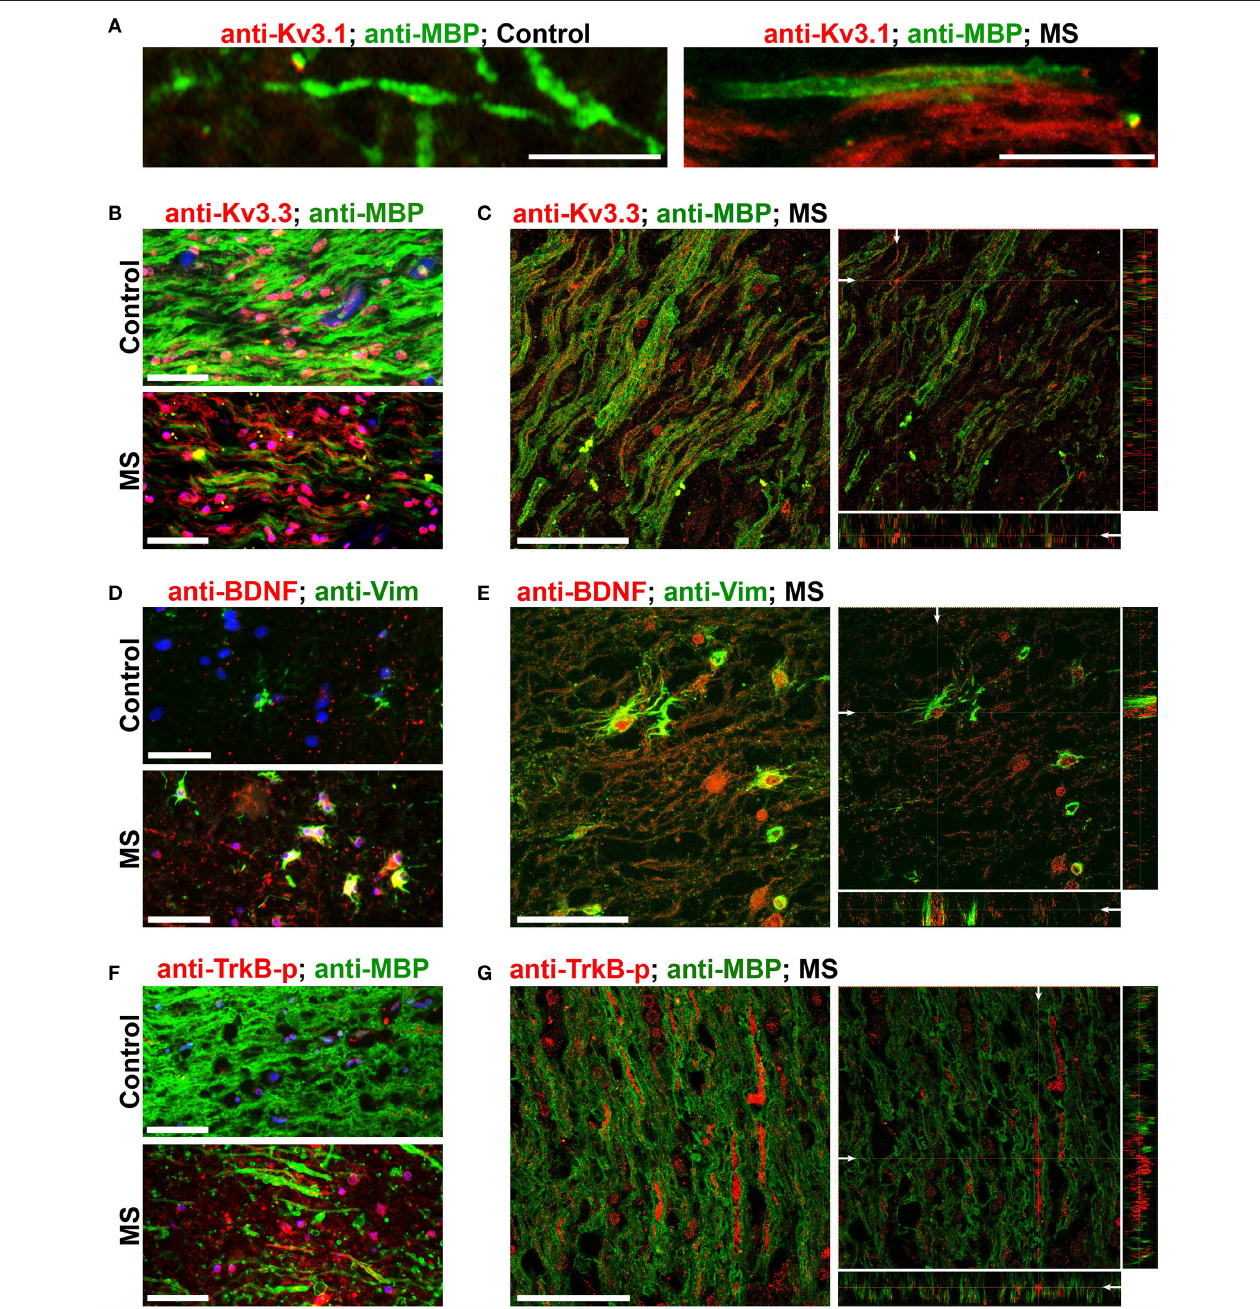
FIGURE 7 | Alterations of Kv3 channels and BDNF in post-mortem tissues of MS patients. (A) Costaining of post-mortem brain sections from a non-MS individual (control) and an MS patient for Kv3.1 (red) and MBP (green). (B) Post-mortem brain sections from a control individual (top) and an MS patient (bottom) were costained for Kv3.3 channels (red) and MBP (green). (C) A 3-D confocal image stack for Kv3.3 (red) and MBP (green) in an MS lesion. (D) Sections from post-mortem brains were costained for Vim (green) and BDNF (red). (E) A 3-D confocal image stack in an MS lesion from (D) . (F) Sections from post-mortem brains were costained for phospho-TrkB (TrkB-p, red) and MBP (green). (G) A 3-D confocal image stack in an MS lesion (F) . Scale bars, 50 µ